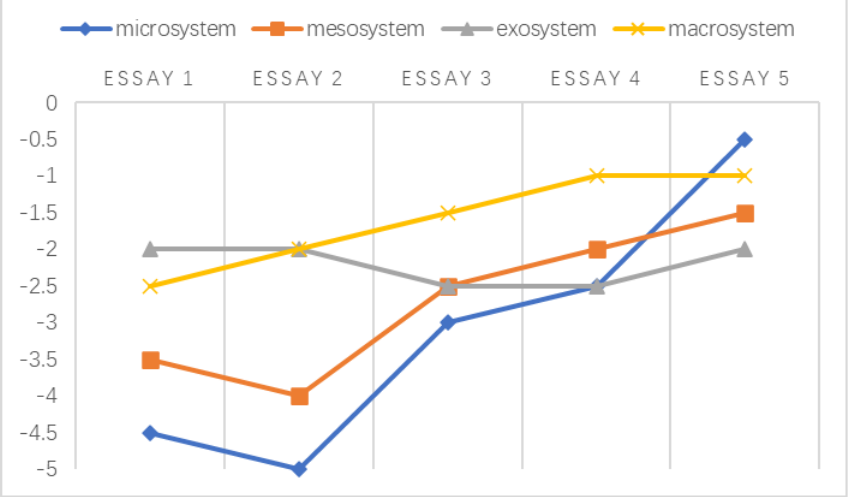
Figure 6. An illustration of T6’s emotional changes in the ecological systems after grading five essays.